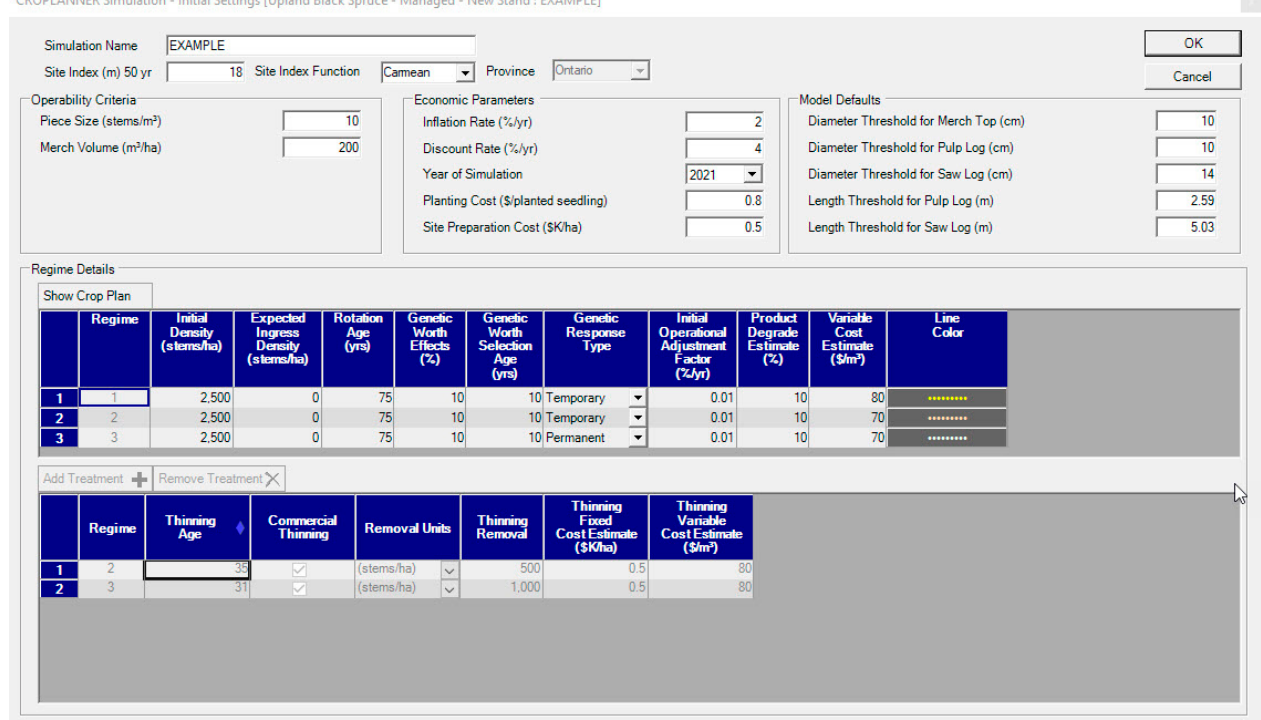
Figure A2. Exemplifying the automated crop plan selection capability of the CP DSS in regard to determining the optimal CT regime within upland black spruce plantations via the deployment of the Value Management Optimizer–CT. Specifically, the auto-populated input GUI dialog screen generated from the optimizer consisting of the selected optimal CT-based crop plan set inclusive of required regime-specific input along with the carried forward operability criteria, economic parameter settings and model (merchantability limits) default values.